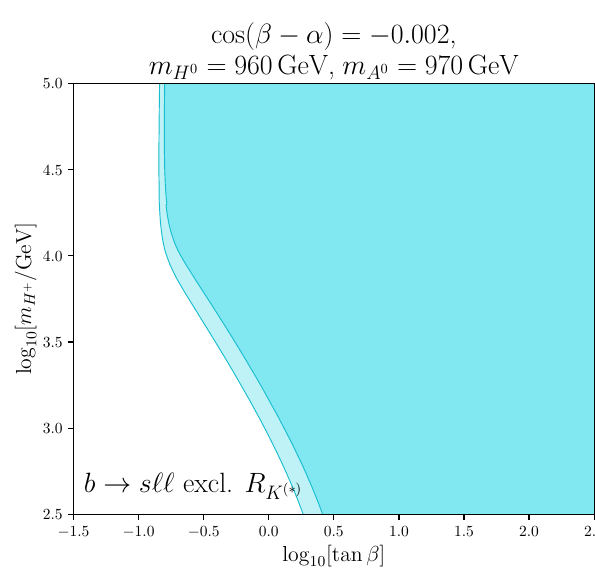
Figure 8 . Contour plot of the allowed 2HDM-I parameter space in the ( tan β − m the combined fit to the leptonic B d,s → µ + µ − decays and the semi-leptonic b → s‘ + ‘ − observables, excluding R and fixing the additional parameters to their best-fit points. The darker contour K ( ∗ ) indicates allowed parameter space at 1 σ confidence, and the lighter at 2 σ